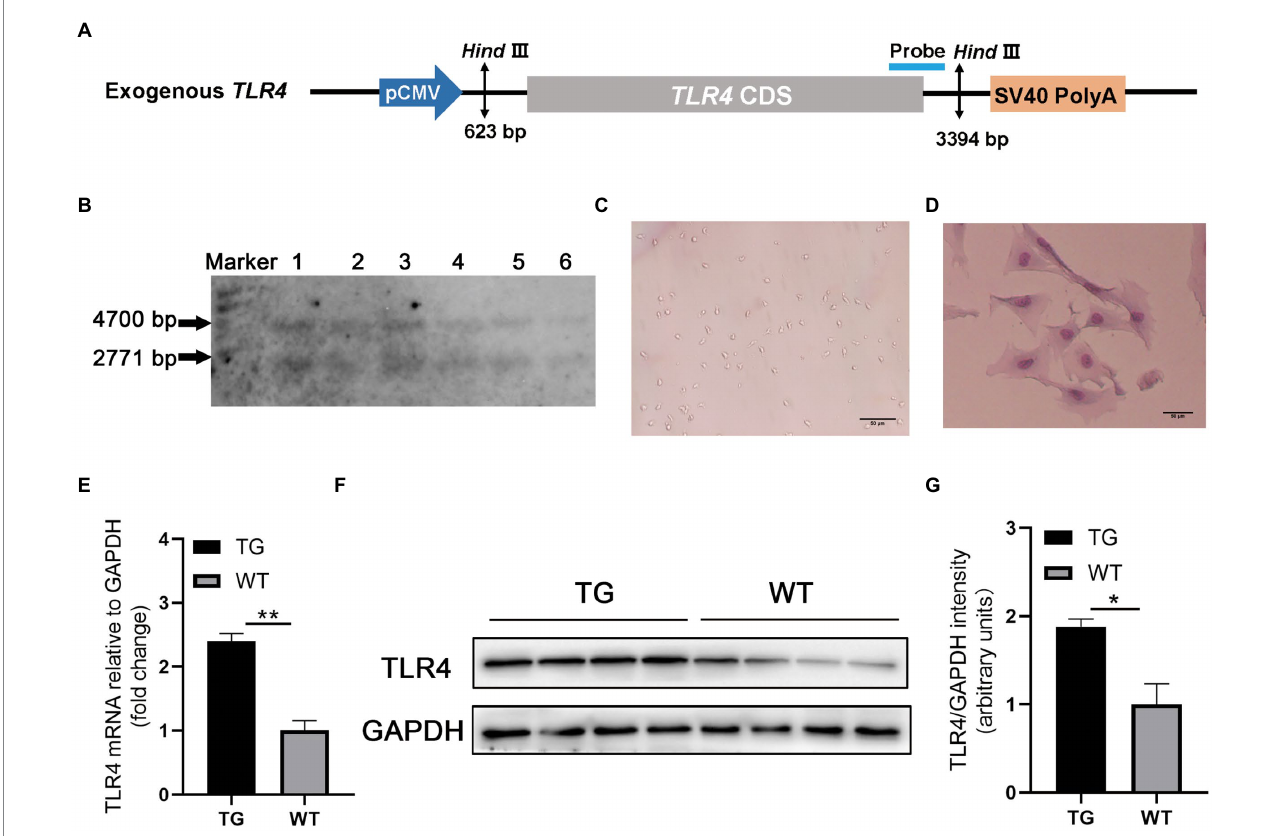
FIGURE 1 TLR4 overexpression assay in sheep. (A) Structure diagram of CMV-ovis aries TLR4 overexpression vector. (B) Identification of TG sheep by representative southern blot based on the presence of the TLR4 transgene. TG sheep have both an endogenous 4,700 bp TLR4 band and an exogenous 2,771 bp TLR4 band. Marker, 1 kb ladder. (C) Morphology of isolated macrophages. (D) Sheep macrophages were isolated from peripheral blood and their morphology was highlighted by Giemsa staining. (E) The mRNA expression of TLR4 in macrophages was examined by qRT-PCR. (F) TLR4 protein expression in macrophages was analyzed using western blotting. Compared with WT macrophages, the TLR4 protein level in TG macrophages was significantly higher. (G) The data of western blot were analyzed statistically. TG, transgenic; WT, wild-type. Error bars indicate SD, N = 4; * p < 0.05, ** p <